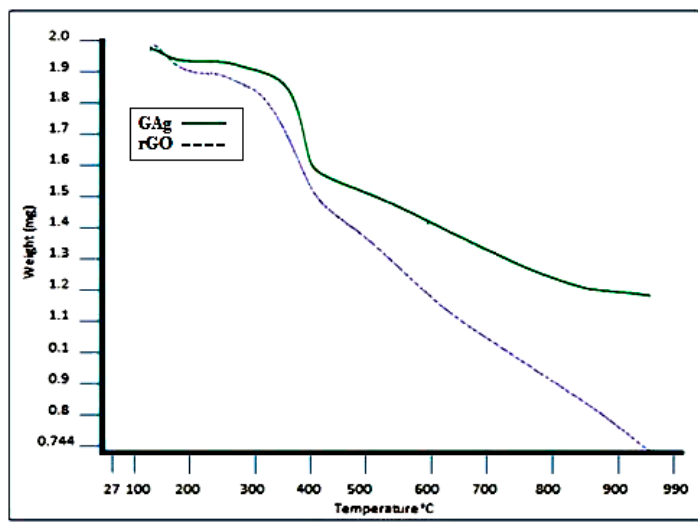
Figure 9. Thermogravimetric (TGA) spectra of rGO and GAg nanocomposites.